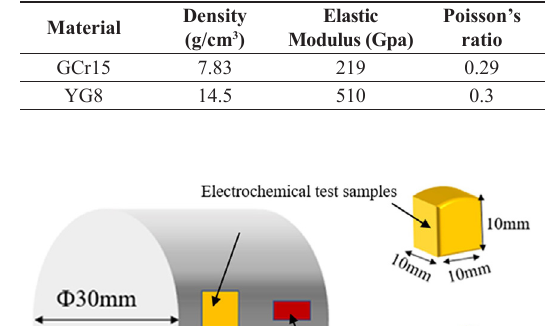
Table 3. Physical properties of materials.